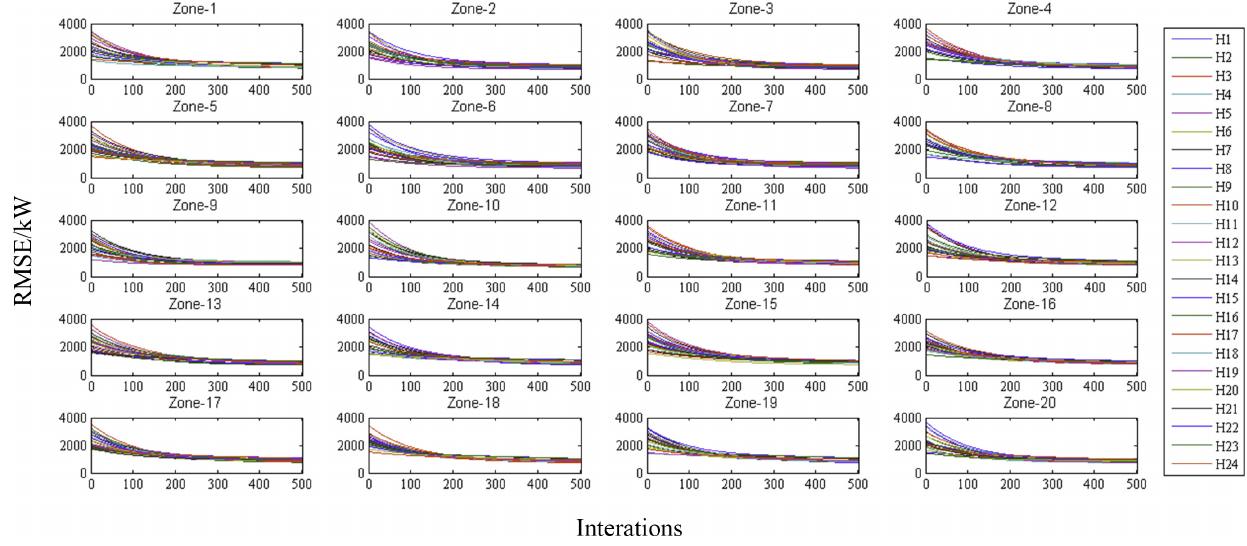
Fig 4. Training errors (RMSE) of 24-hour models for all 20 zones at different iterations. The sub-figures (labelled Zone-1 to Zone-20) represent the RMSE for each zone for the 24 models trained over 24 hours. The training errors for the different hours (H1 to H24) are shown in different colours. The same colours and symbol codes are applied to each zone.